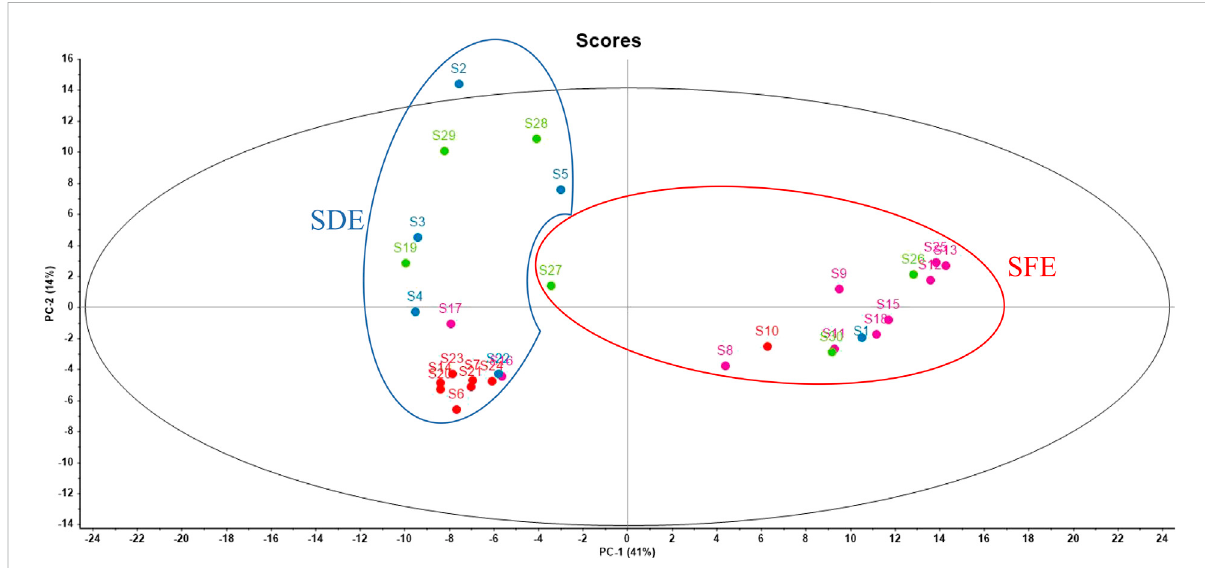
FIGURE 8 PCA scatter diagram of 30 AEOs. Each dot represents each sample (S1-S30). The origin is indicated by the color of the dots. Red dots: Hainan, China; Green dots: Guangxi, China; Rose red dots: Guangdong, China; Blue dots: Southeast Asian countries. The extraction method is represented by circle curve. Red circle: SFE samples; Blue circle: SDE